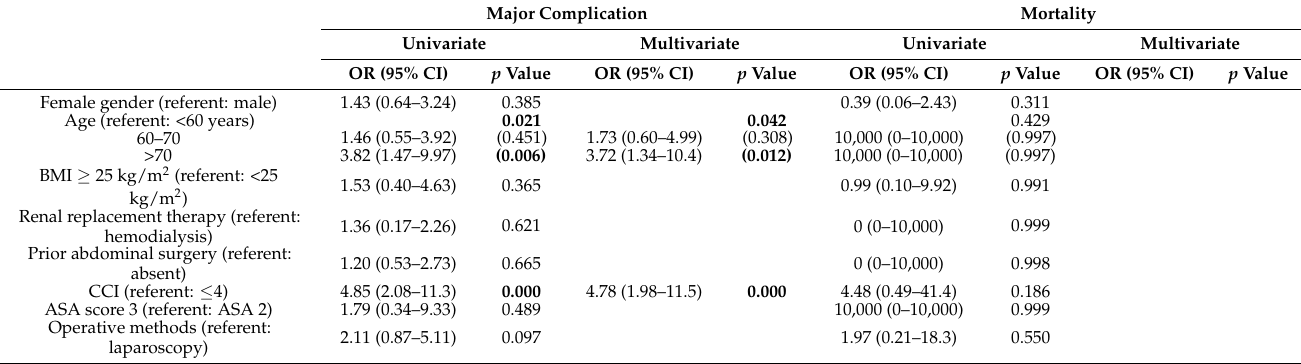
Table 4. Univariate and multivariate logistic regression for predictive factors of postoperative major complications and mortality.